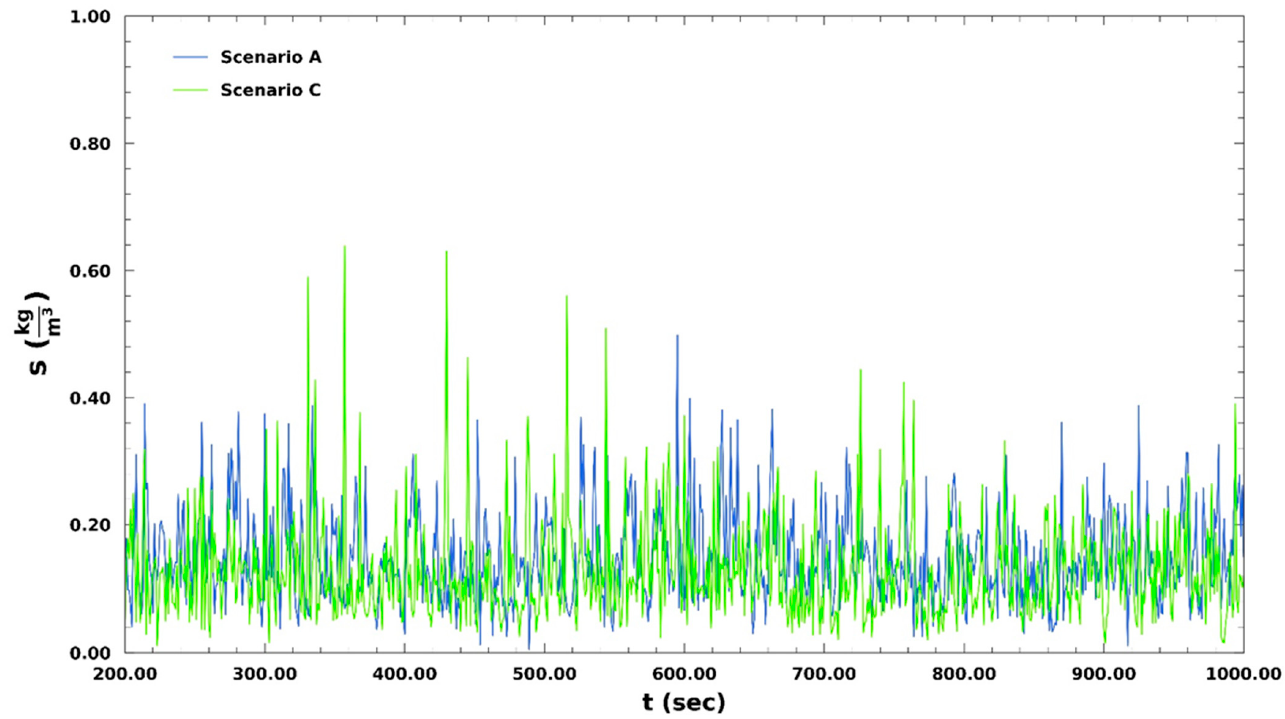
Figure 8. Concentration of the pollutant for Scenarios A and C at the position with coordinates of X: